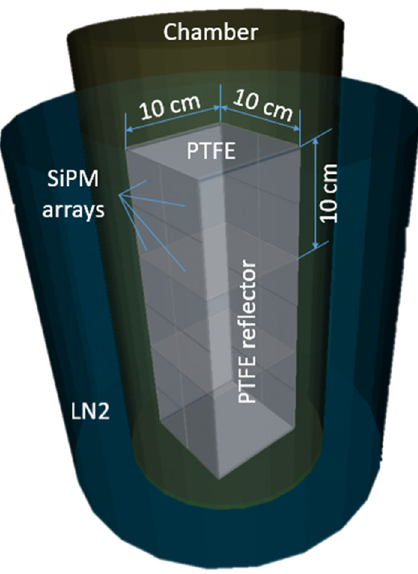
Fig. 12 A simplified 3D drawing of a ∼ 10 kg detector module